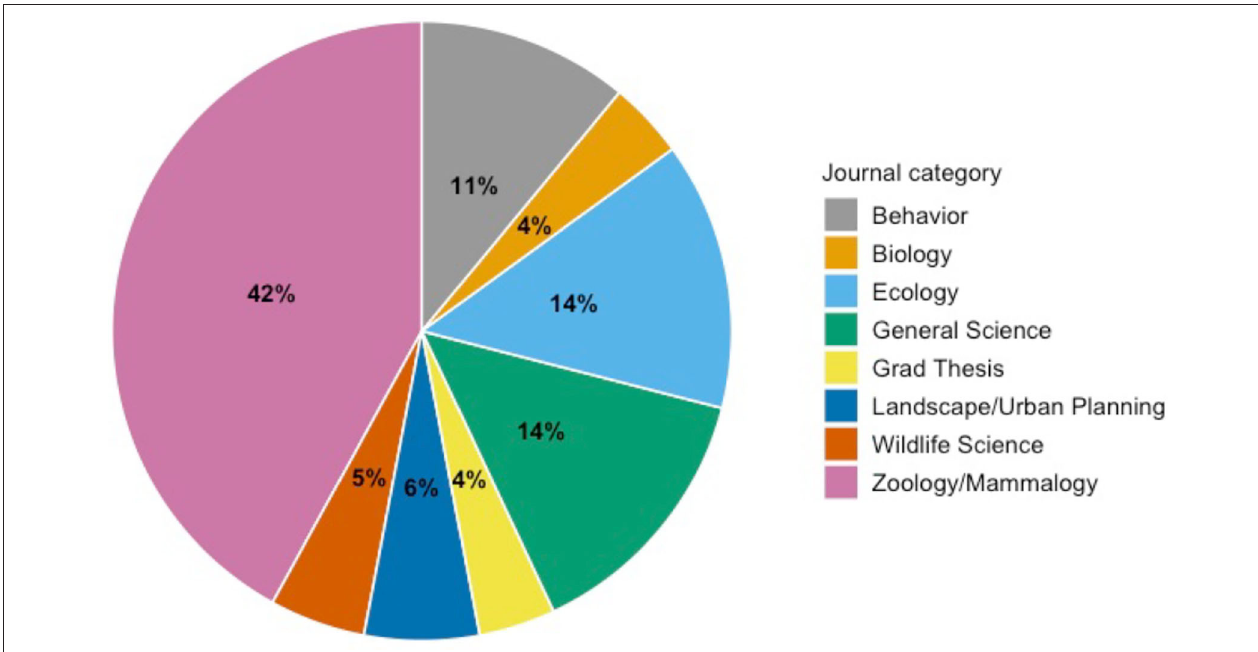
FIGURE 1 | Publication categories of journals that published urban mammal behavior change studies between 1987 and 2020 with percentages of papers in each category.